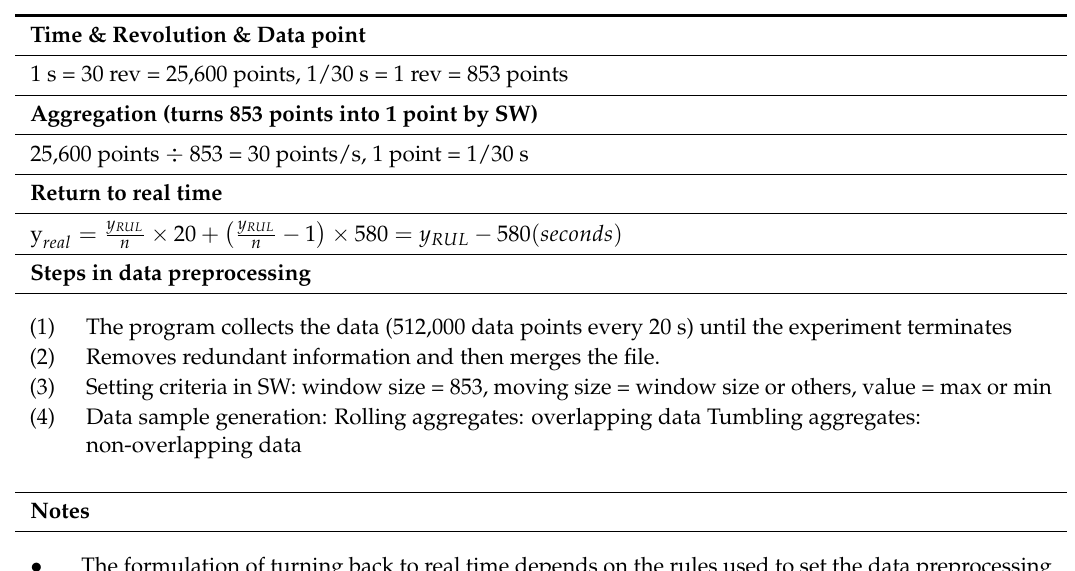
Table 2. Summary of data